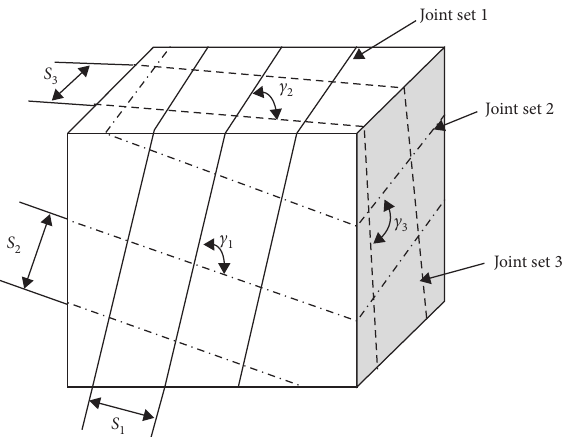
Figure 8: Joint sets and angle between joint sets